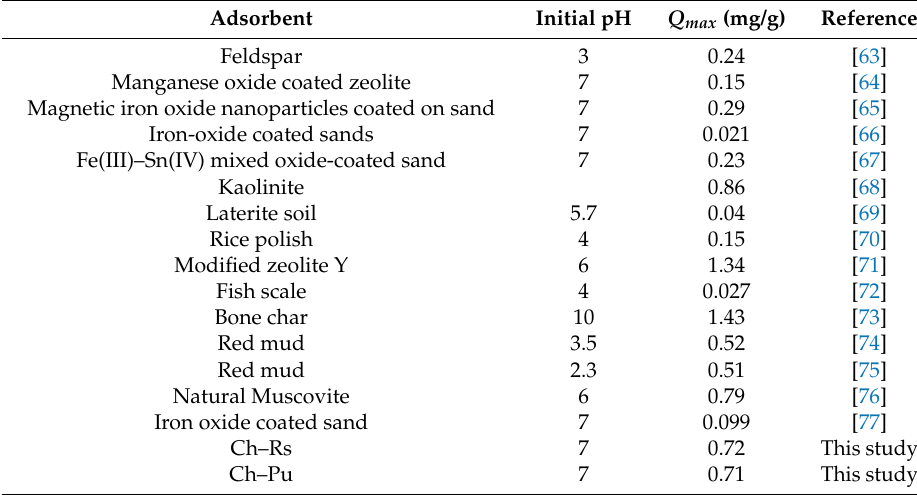
Table 4. Comparison of maximum adsorption capacity ( Q max , mg/g) of various low cost adsorbents for As (V)